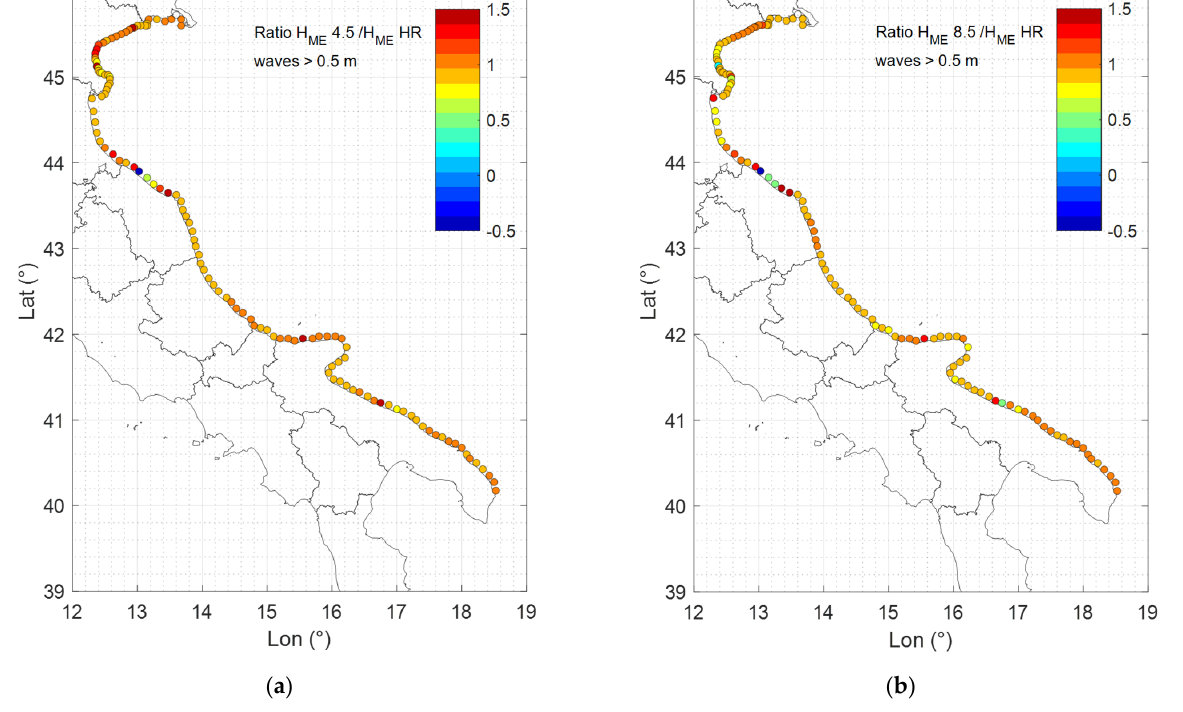
Figure 11. Ratio between historic and future net H ME computed with all the waves larger than 0.5 m at the 120 virtual buoys along the Italian Adriatic coast. ( a ) Historic run vs. RCP 4.5 scenario; ( b ) historic run vs. RCP 8.5 scenario. Blue points indicate that the direction of the sediment transport is